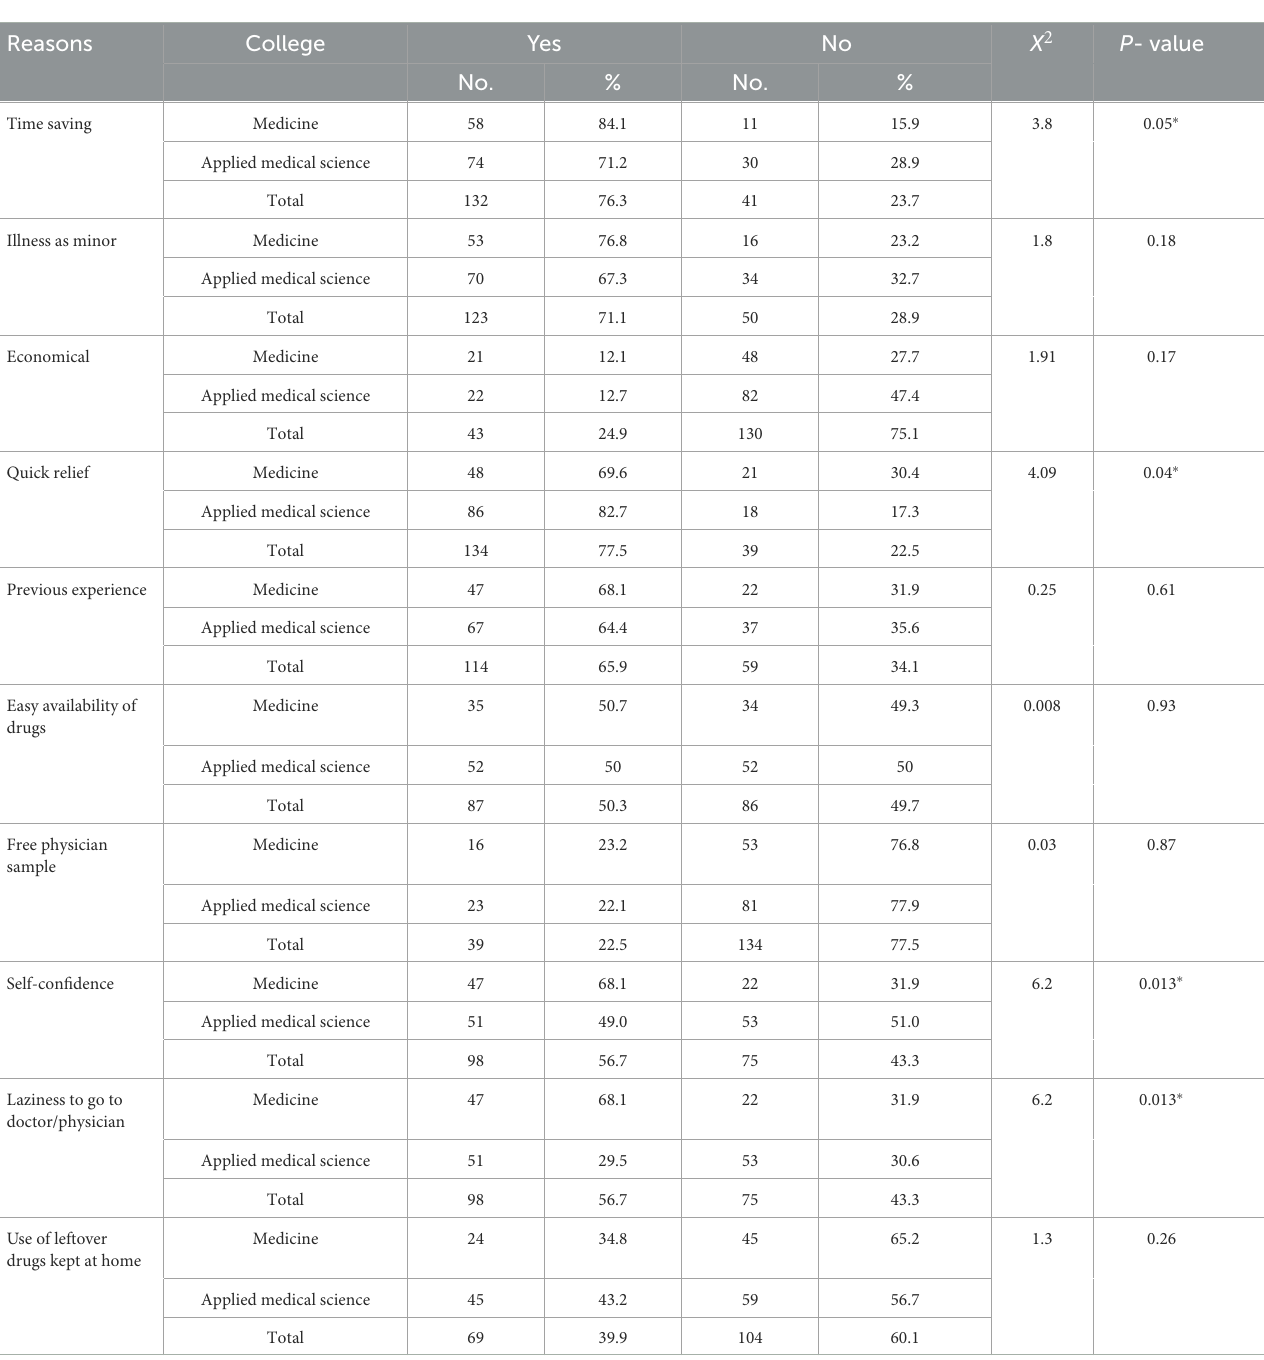
TABLE 2 Reasons for self-medication ( N =